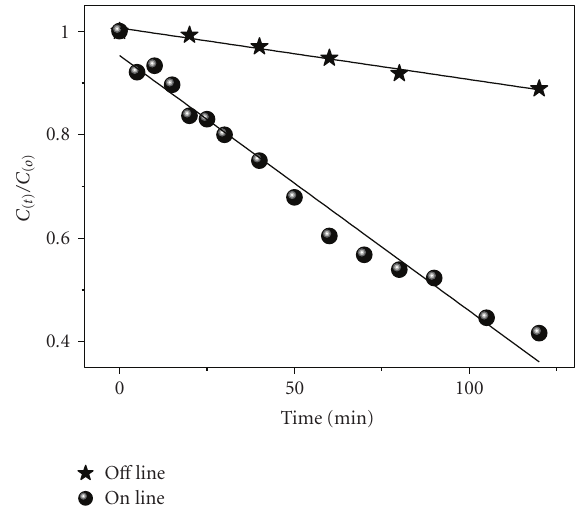
Figure 5: Profile from the decay of the concentration of para- cetamol obtained by the standard HPLC method (o ff -line) and by the on-line system proposed, as a function of the electrol- ysis time. Electrolysis was conducted by applying 100mAcm − 2 using 2.0L of electrolyte solution of 0.1molL − 1 K 2 SO 4 and 5.0 × 10 − 4 molL − 1 FeSO 4 · 7H 2 O containing 1.35 × 10 − 2 molL − 1 parac- etamol.